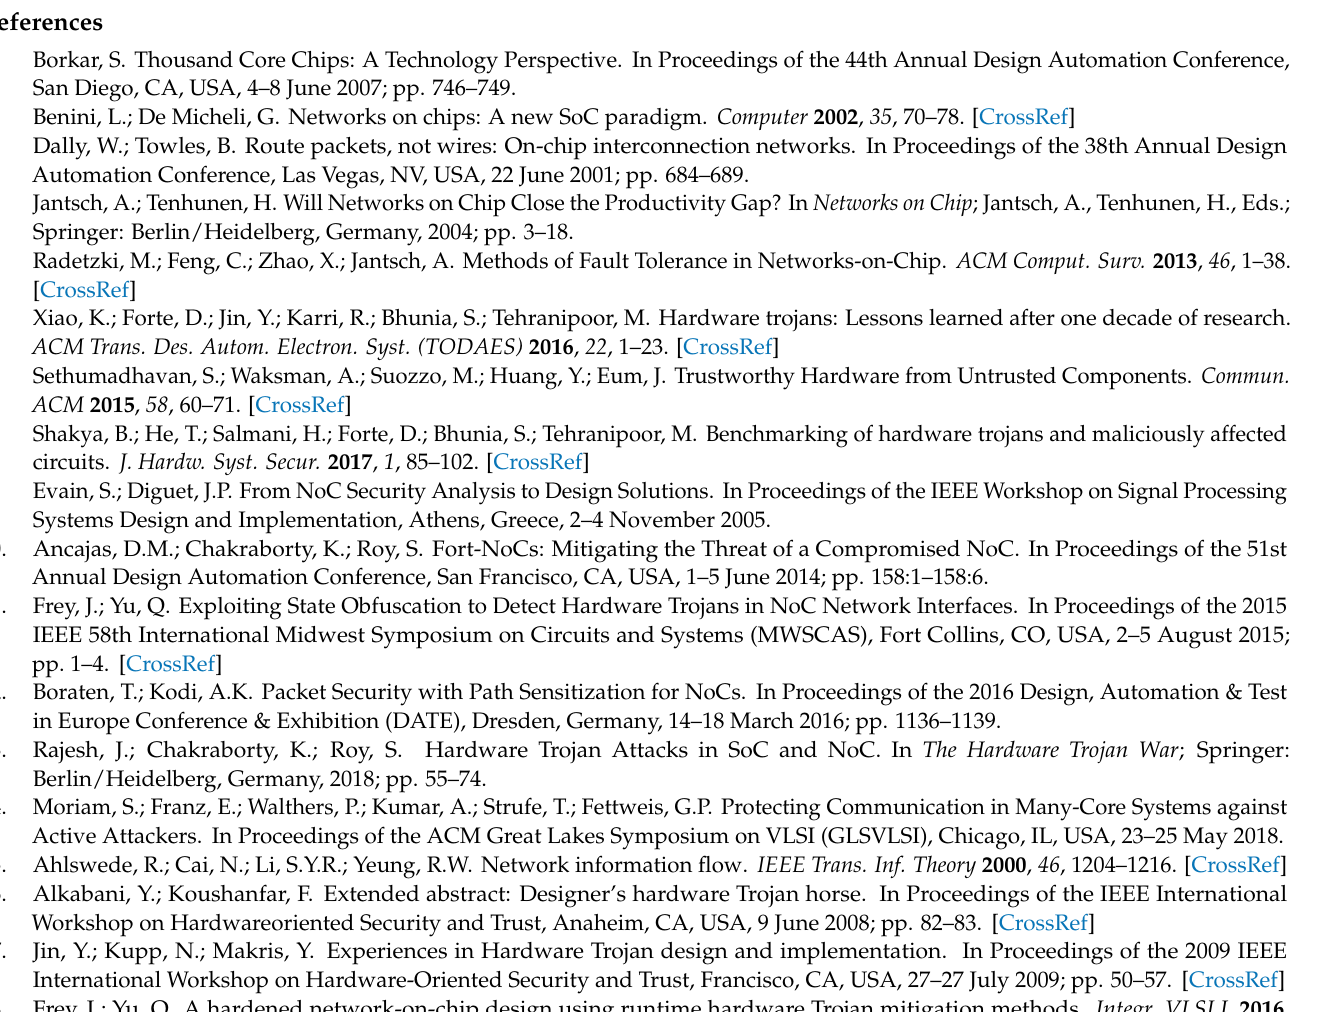
Figure A4. Simulation results for 8 × 8 2D mesh with 16 attacking